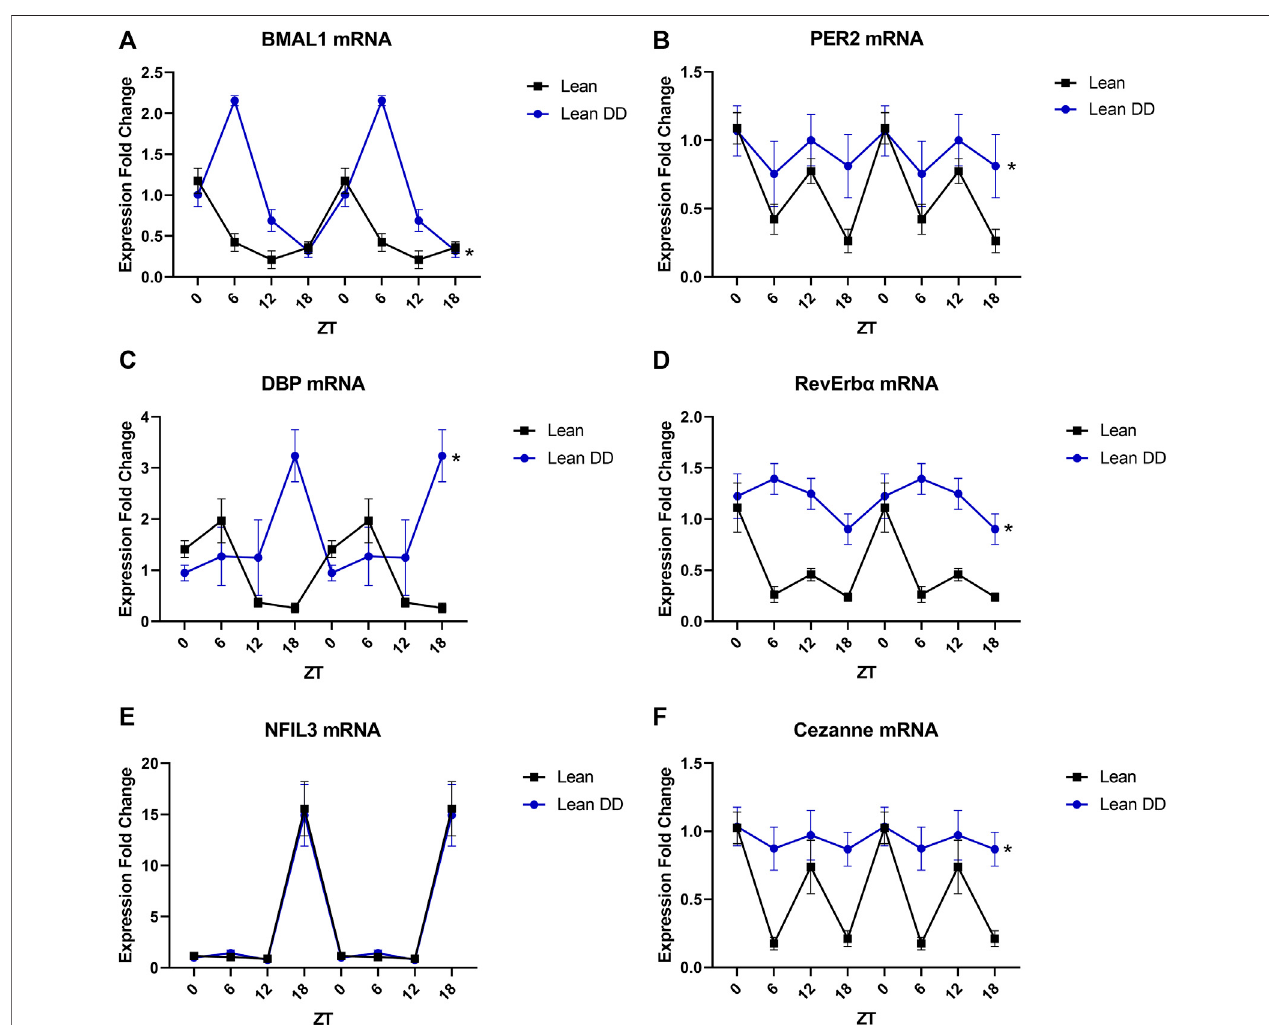
FIGURE 4 | Diurnal disruption partially alters the transcriptional pro fi le of endothelial cells. (A). BMAL1 mRNA levels in freshly isolated mesenteric endothelial cells from male 20-week old lean mice with and without exposure to constant darkness ( n = 3 – 6). (B). PER2 mRNA levels in freshly isolated mesenteric endothelial cells from male 20-week old lean mice with and without exposure to constant darkness ( n = 3 – 6). (C). DBP mRNA levels in freshly isolated mesenteric endothelial cells from male 20-week old lean mice with and without exposure to constant darkness ( n = 3 – 6). (D). RevErb α mRNA levels in freshly isolated mesenteric endothelial cells from male20-week old lean mice with and without exposure toconstant darkness ( n = 3 – 6). (E). NFIL3 mRNA levels in freshly isolated mesenteric endothelialcells from male 20-weekoldleanmicewithandwithoutexposuretoconstantdarkness( n =3 – 6). (F). CezannemRNAlevelsinfreshlyisolatedmesentericendothelialcellsfrommale20- week old lean mice with and without exposure to constant darkness ( n = 3 – 6). All data are represented as mean ± SEM.